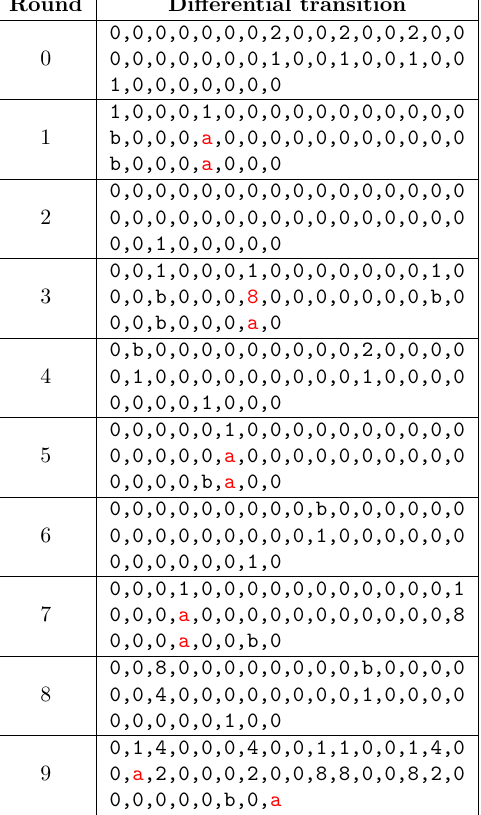
Table 10: A corrected best 10-round TK1 differential characteristic of SKINNY-64 , originally from Table 6 of [DDH + 20]. The first, second and third row in each cell of the table represent the difference before SB, the difference after SB and the round key involved respectively in hexadecimal notation. The values highlighted in red are the entries that differ from the original differential characteristic. The independent probability is 2 − 42 working with 2 − 3 of the key